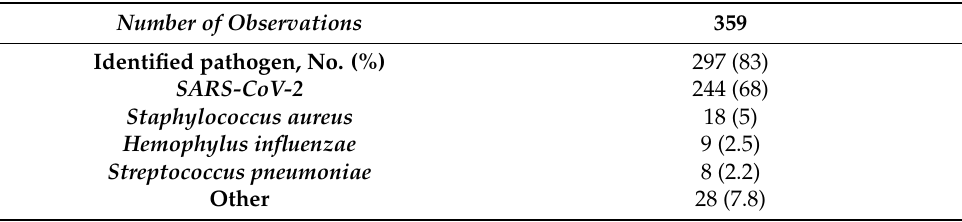
Table 2. Etiological diagnosis using microbiological and molecular